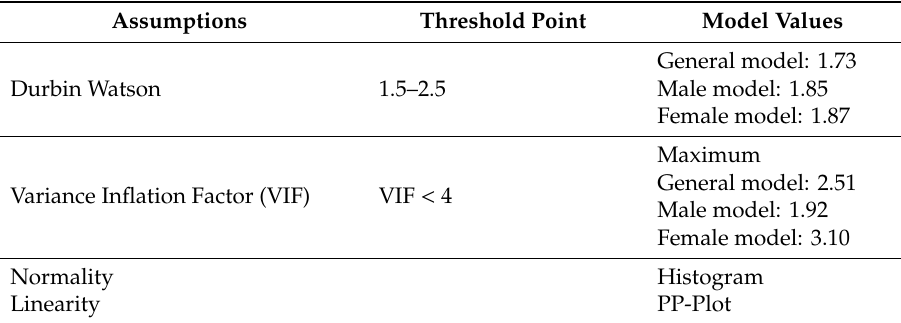
Table 3. Data suitability for parametric statistical